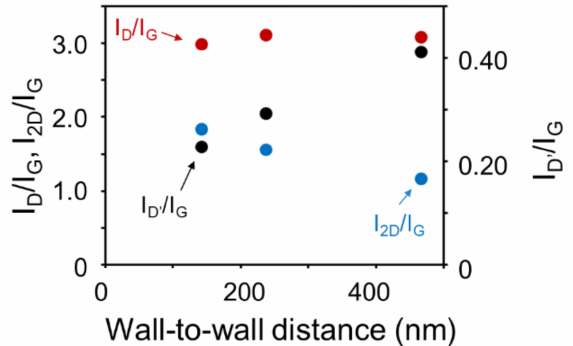
Figure 3. Peak area intensity ratios of I D /I G , I D’ /I G , and I 2D /I G in Raman spectra of CNWs with wall-to-wall distances of 142, 237, and 467 nm synthesized at V in of 0, 90, and 120 V, respectively. The wettability of the CNWs surface was also evaluated by contact angle measure- ments of water droplets. The CNWs with average wall-to-wall distances of 142, 237